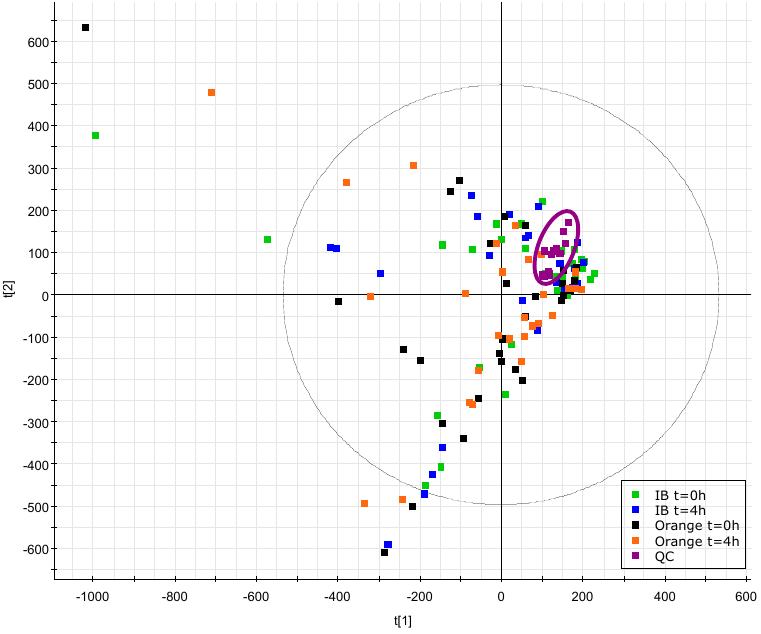
Figure 1. PCA score plot component 1 vs. component 2 of Hydrophilic Interaction Liquid Chromatography (HILIC) in positive ionization mode, explaining the 20.6% and 17.7% of the variance, respectively. The purple points (14 QC samples) are grouped and centered in the plot. Four plasma samples were obtained from each of the 30 participants obtaining 30 samples per group. A total of 120 plasma samples were analyzed. The samples obtained at t = 0 h and t = 4 h after the intake of an isocaloric beverage (IB) and the samples obtained at t = 0 h and t = 4 h after orange intake are colored in green, blue, black and orange, respectively.